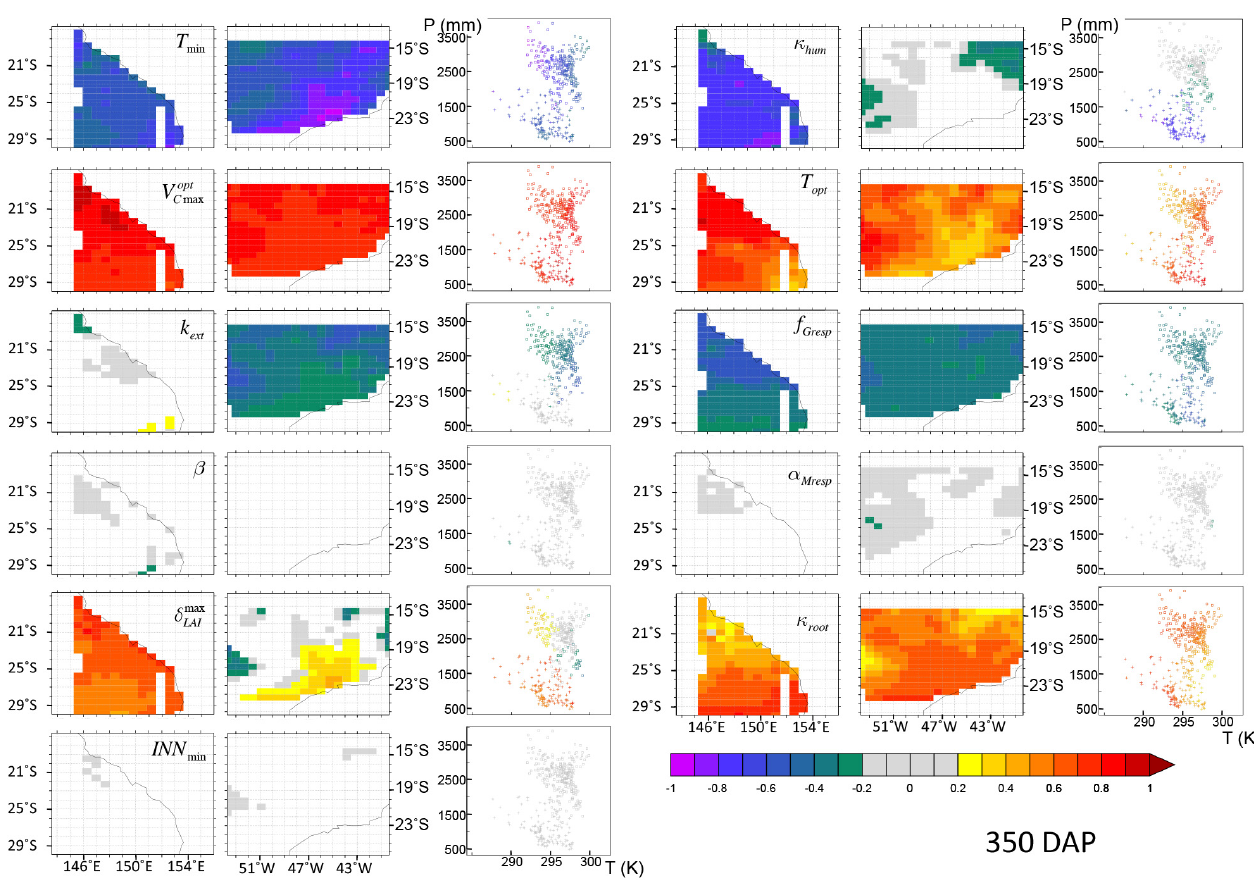
Figure 12. Sensitivity of ORCHIDEE–STICS to its main parameters at 350 days after planting, as measured with partial ranked correlation coefficients (PRCC). The color indicates the strength of the relation between the parameter and the harvestable biomass, which is represented spatially (columns 1 , 2 , 4 , 5) and in a (temperature, precipitation) referential (columns 3 ,